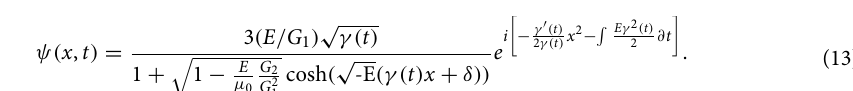
1 , = 0.4 , E 1 , 1.5 , M 2 / 9 , G 1 = = − = = − 1 and =